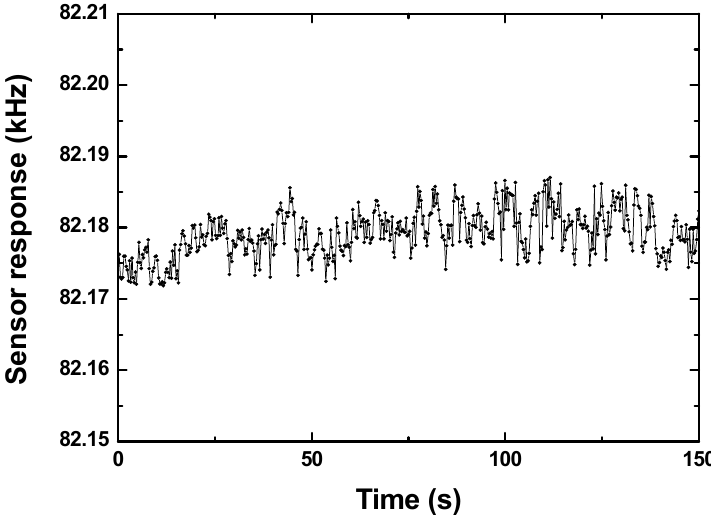
Figure 2. The experimental setup for characterizing the prepared sensing devices.